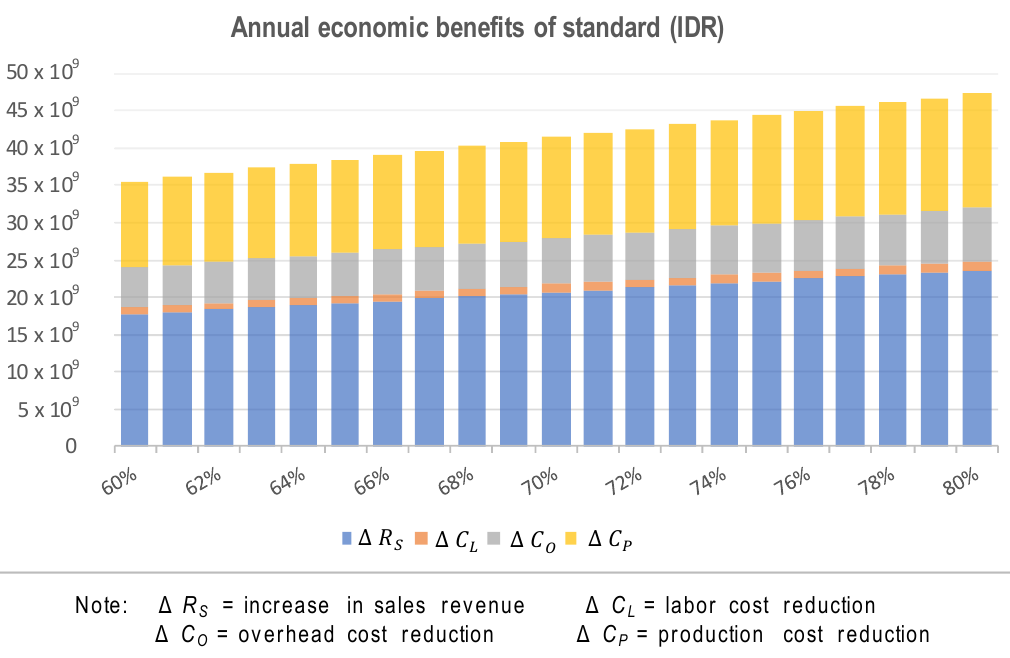
Figure 10. Projected economic benefits of swappable battery standard.